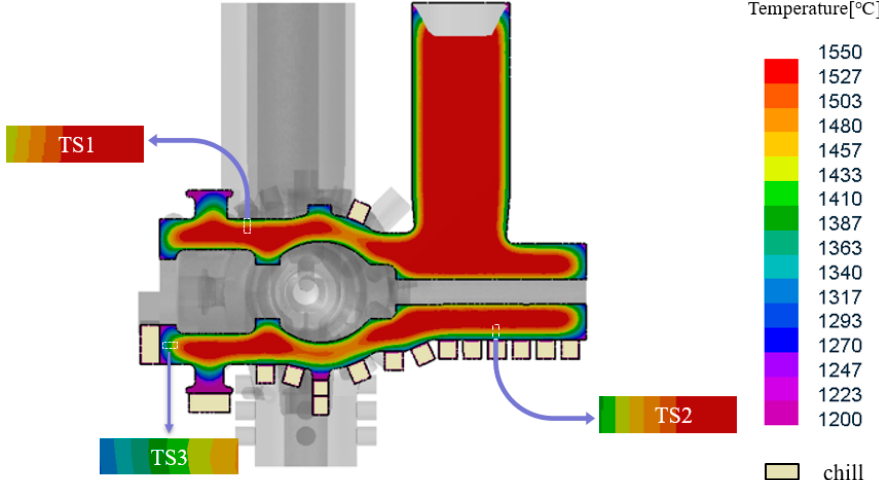
Figure 1. Temperature field and thermal simulation sampling position of heavy ferritic heat-resistant steel (FHRS) casting, t = 0.5 h.